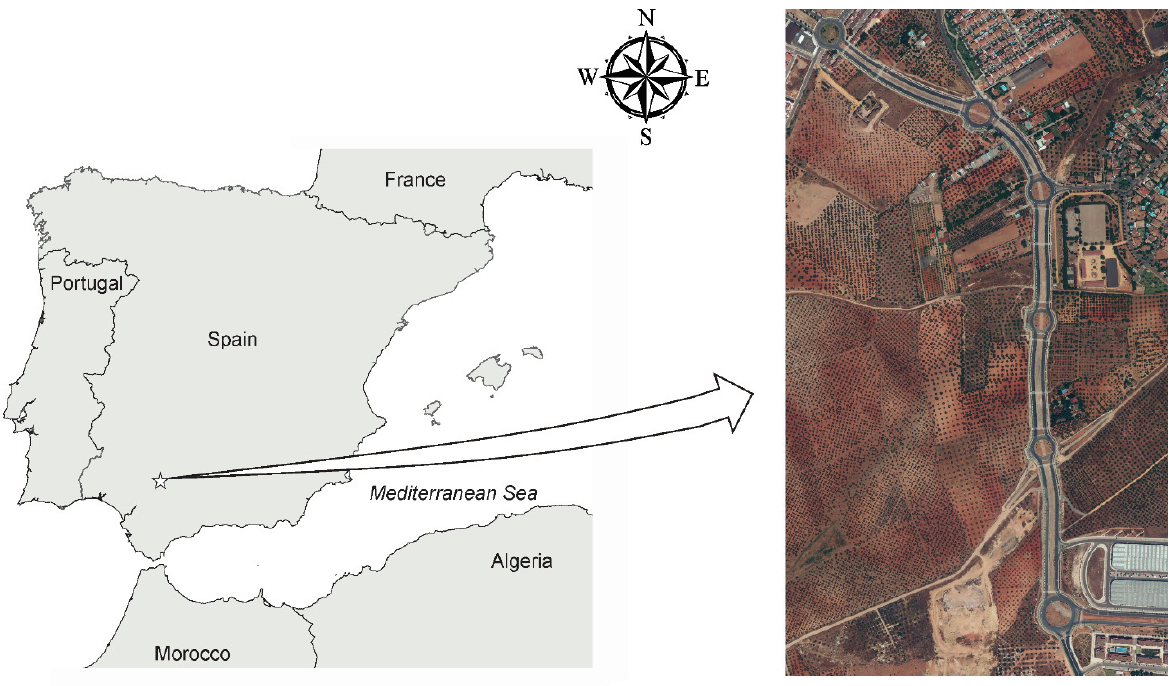
Figure 1. Overview of the study